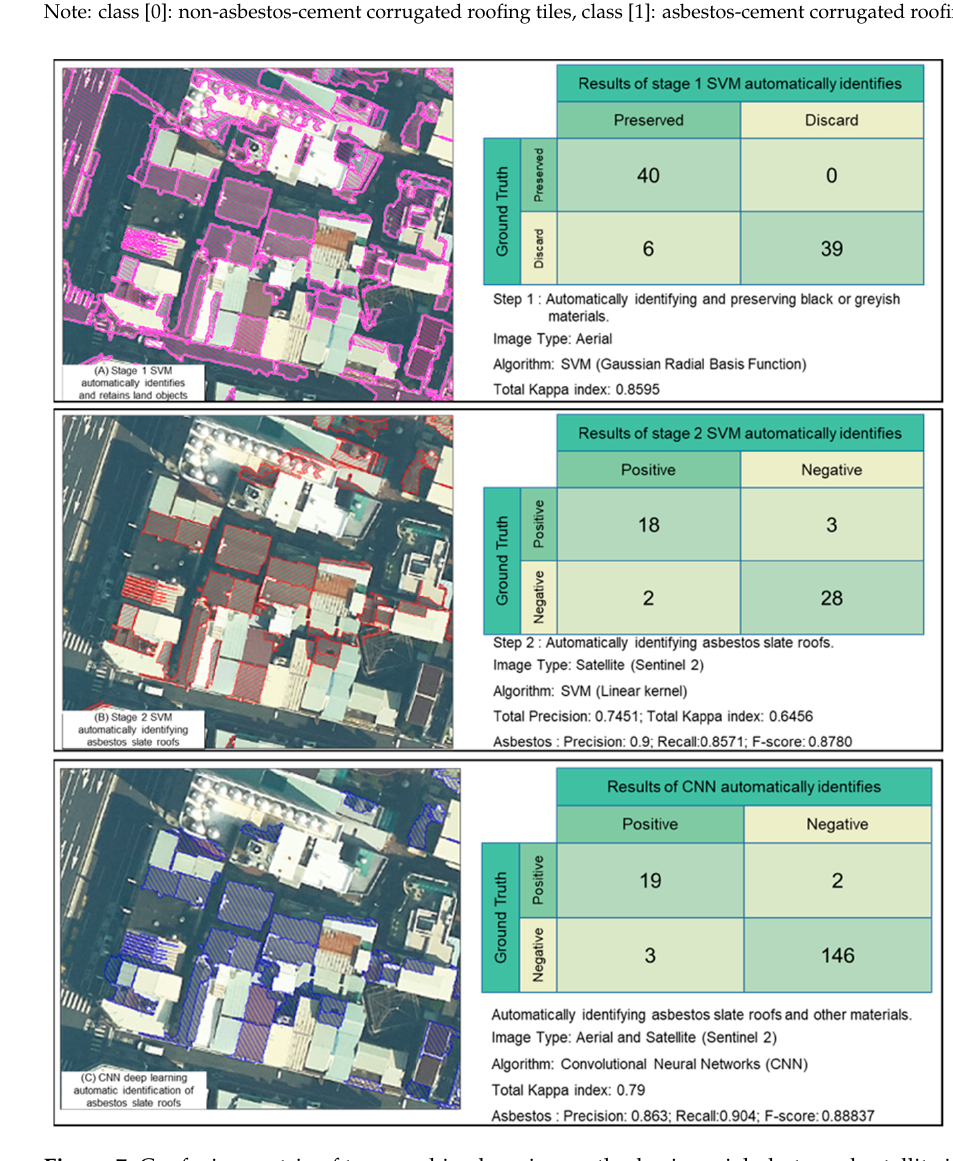
Figure 7. Confusion matrix of two machine learning methods via aerial photo and satellite